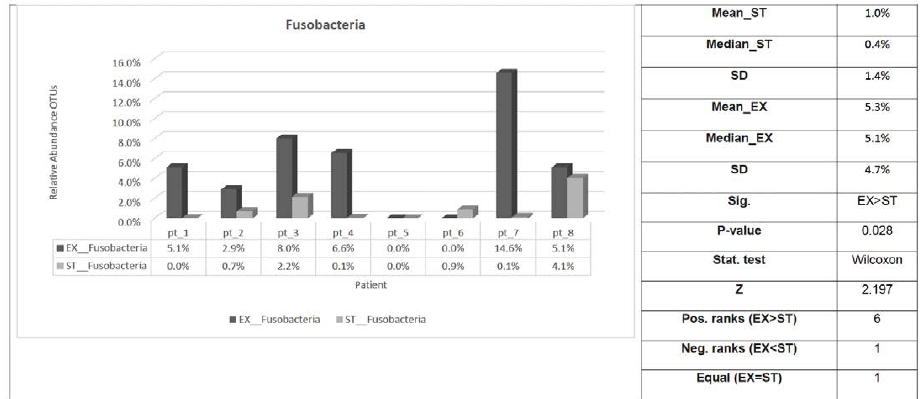
Figure 4. Fusobacteria phylum distribution of sputum samples from eight ACO patients in the EX versus ST states. Sig: indicates whether a statistically significant difference exists ( p -value < 0.05) between EX and ST; Stat. test: the statistical test used; Z: standardized test statistic; Pos. ranks: the number of positive differences between EX and ST in the paired samples; Neg. ranks: the number of negative differences between EX and ST in the paired samples; Equal: the number of patients where there was no difference between EX and ST. ST: stable; EX: exacerbation; SD: standard deviation.